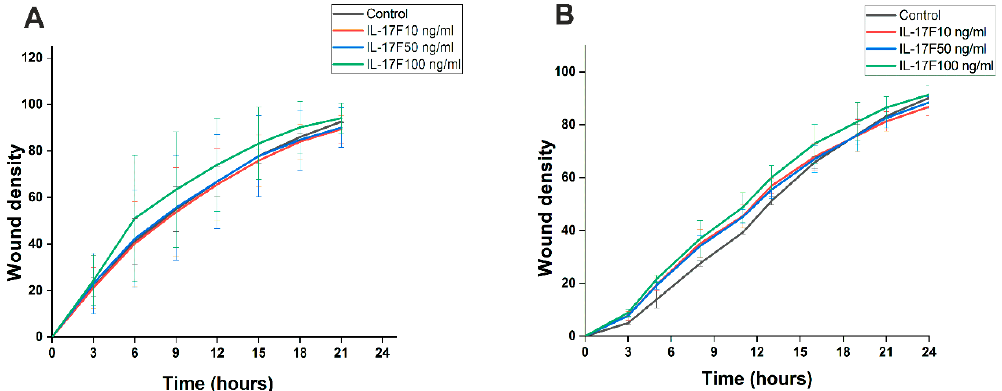
Figure 5. Assessing the e ff ects of IL-17F on cancer cell invasion in a scratch-wound assay. ( A ) HSC-3 cells showed no change in invasiveness when treated with 10, 50, and 100 ng / mL IL-17F for 24 h. ( B ) SCC-25 cells also did not show any observable change in invasiveness when treated with the same concentrations of IL-17F for 24 h. Data are presented as means ± standard